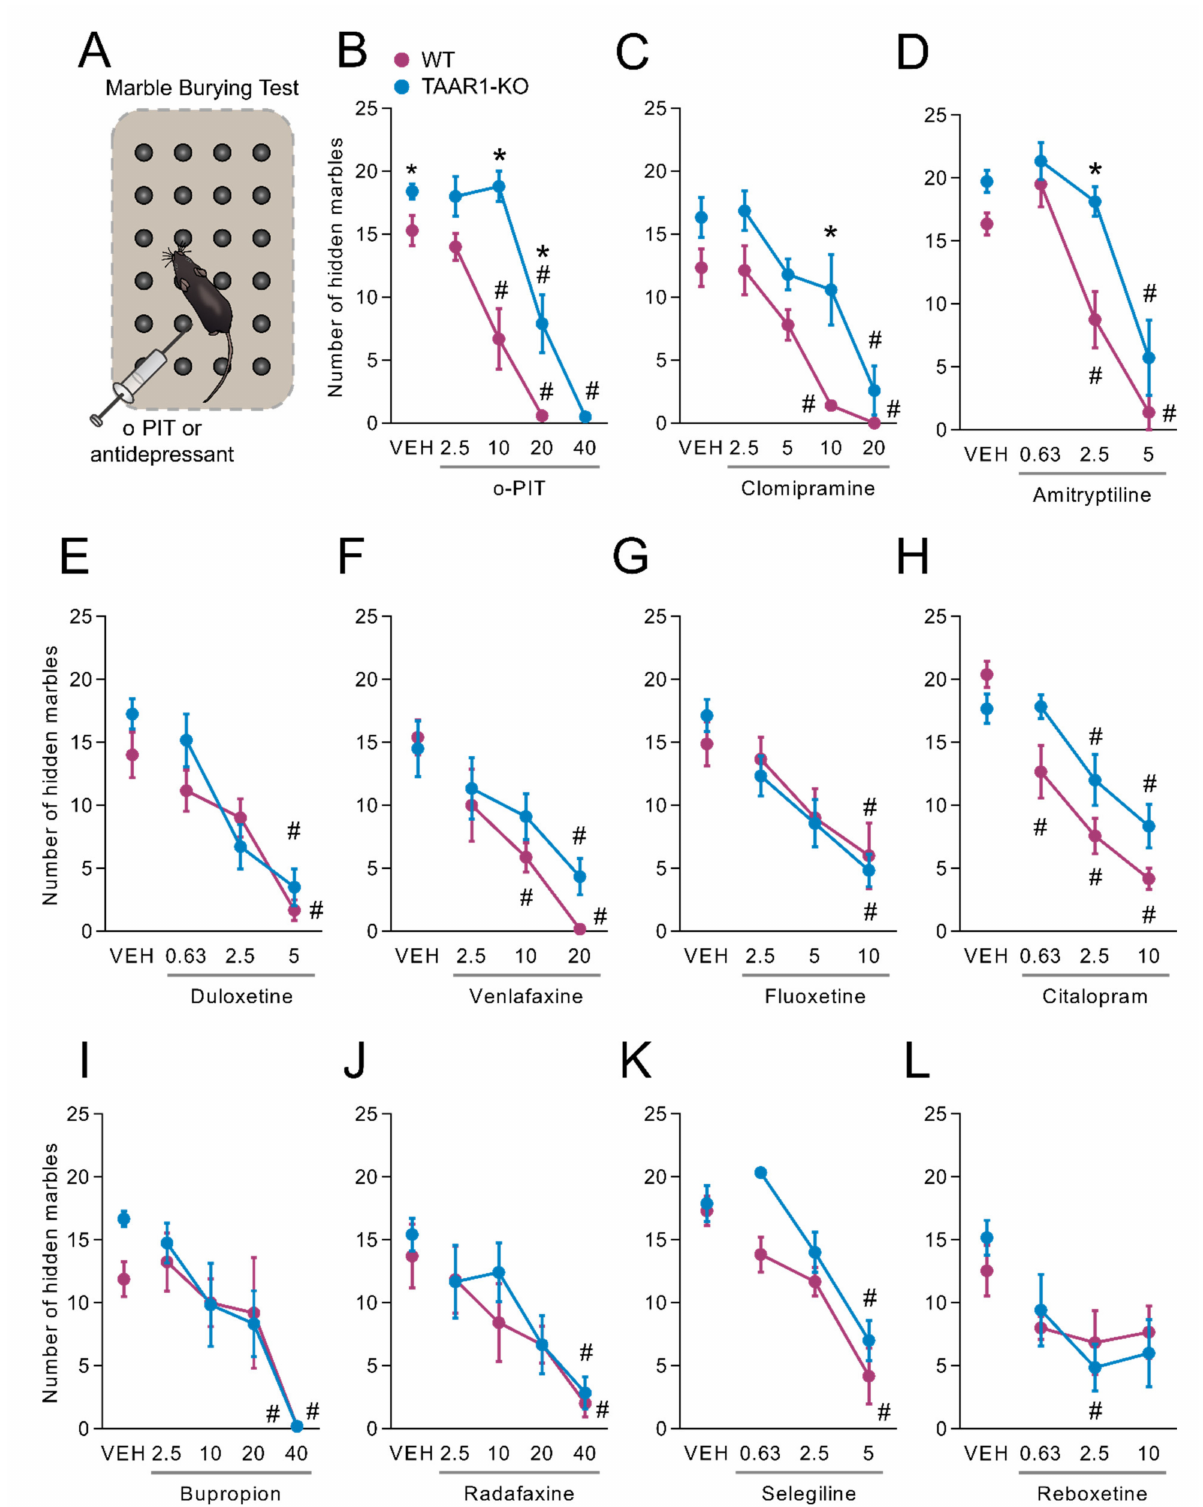
Figure 8. Influence of o-PIT on marble-burying in TAAR1-KO and WT mice. ( A ) Schematic depiction of marble-burying test. ( B – L ) Values correspond to the number of hidden marbles over 30 min after acute o-PIT treatment (2.5–40 mg/kg) ( B ), clomipramine (2.5–20 mg/kg) ( C ), amitriptyline (0.63–5 mg/kg) ( D ), duloxetine (0.63–5 mg/kg) ( E ), venlafaxine (2.5–20 mg/kg) ( F ), fluoxetine (2.5–10 mg/kg) ( G ), citalopram (0.63–10 mg7 kg) ( H ), bupropion (2.5–40 mg/kg) ( I ), radafaxine (2.5–40 mg/kg) ( J ), selegiline (0.63–5 mg/kg) ( K ) and reboxetine (0.63–40 mg/kg) ( L ). Data represent means ± SEM. N = 8–12 per group. p < 0.05, influence of treatment (#) or genotype (*). VEH: